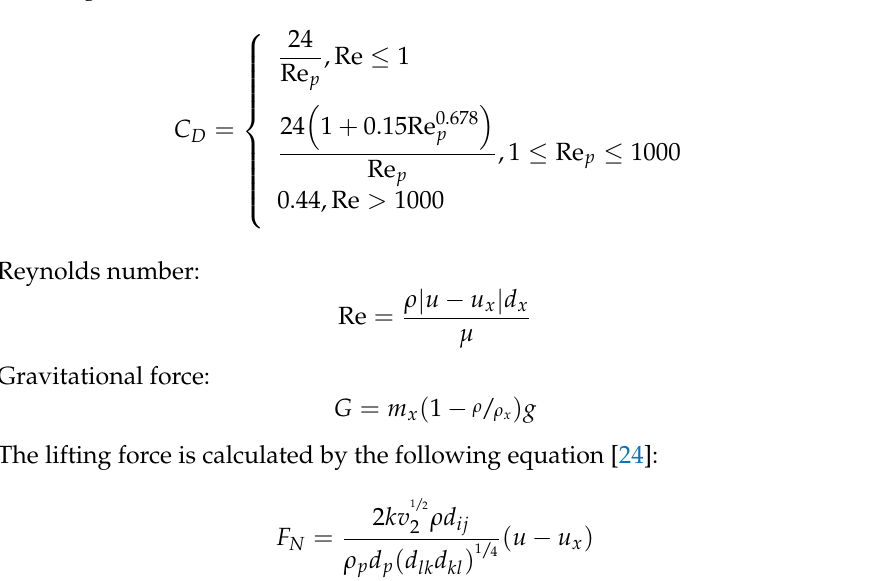
Table 2. Discrete phase main parameters.